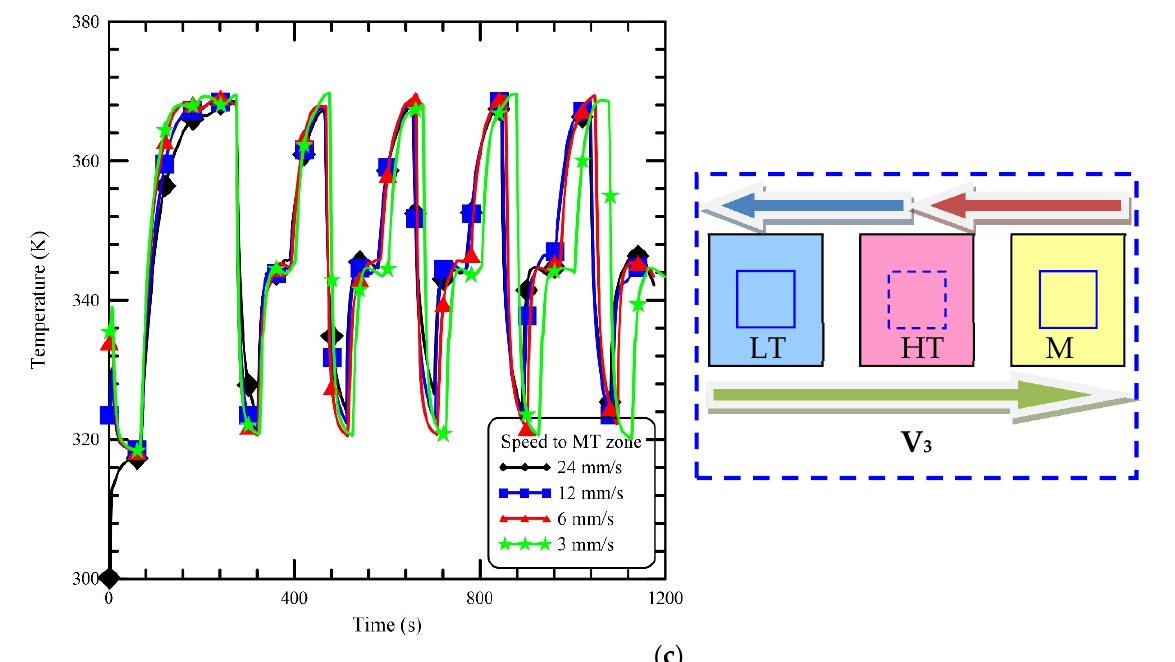
Figure 6. The influence of various travelling speeds on the reaction chamber temperatures. ( a ) The temperature profiles of the chamber travelling from the MT zone to the HT zone at the speeds of 24 mm/s, 12 mm/s, 6 mm/s, and 3 mm/s. ( b ) The temperature profiles of the chamber travelling from the HT zone to the LT zone at the speeds of 24 mm/s, 12 mm/s, 6 mm/s, and 3 mm/s. ( c ) The temperature profiles of the chamber travelling from the LT zone to the MT zone at the speeds of 24 mm/s, 12 mm/s, 6 mm/s, and 3 mm/s.